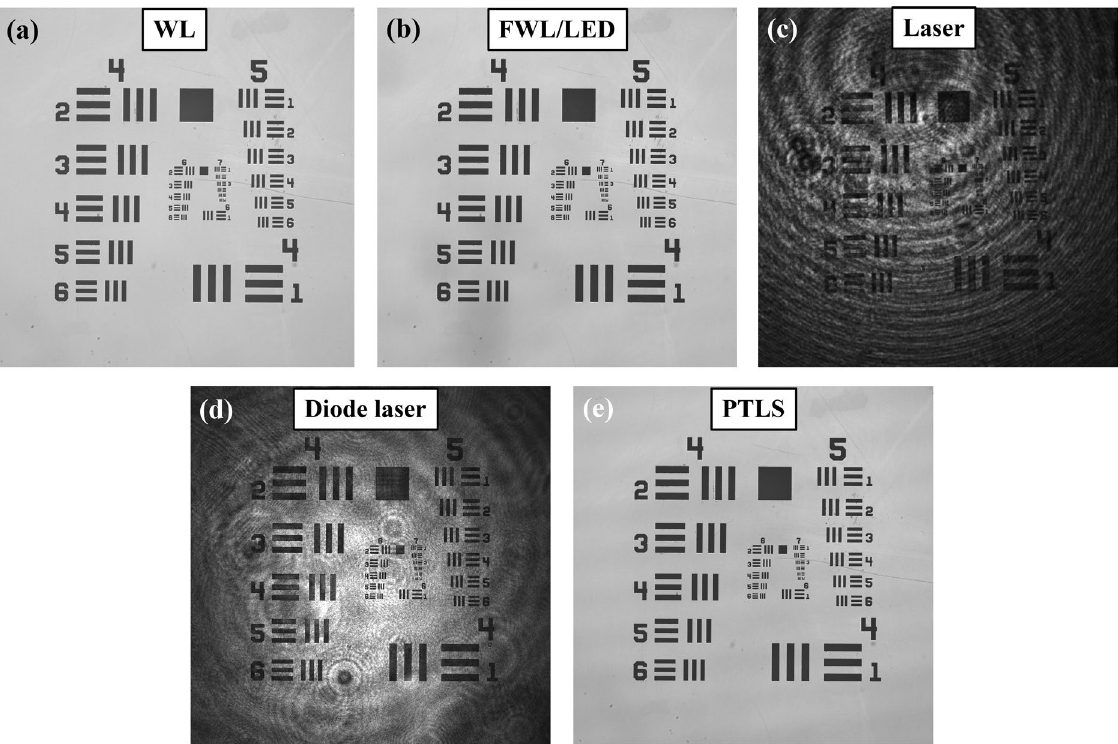
Figure 2. Different light sources for microscopic imaging. Different light sources are compared in terms of the coherent noise in non-interferometric images of USAF resolution chart. Low temporal coherent light sources like white light (WL) and filtered white light (FWL) produce noise free optical images, whereas direct laser generates coherent noise in the images. On the contrary, pseudo-thermal light source generates images comparable to the WL/FWL keeping the advantages of monochromatic light